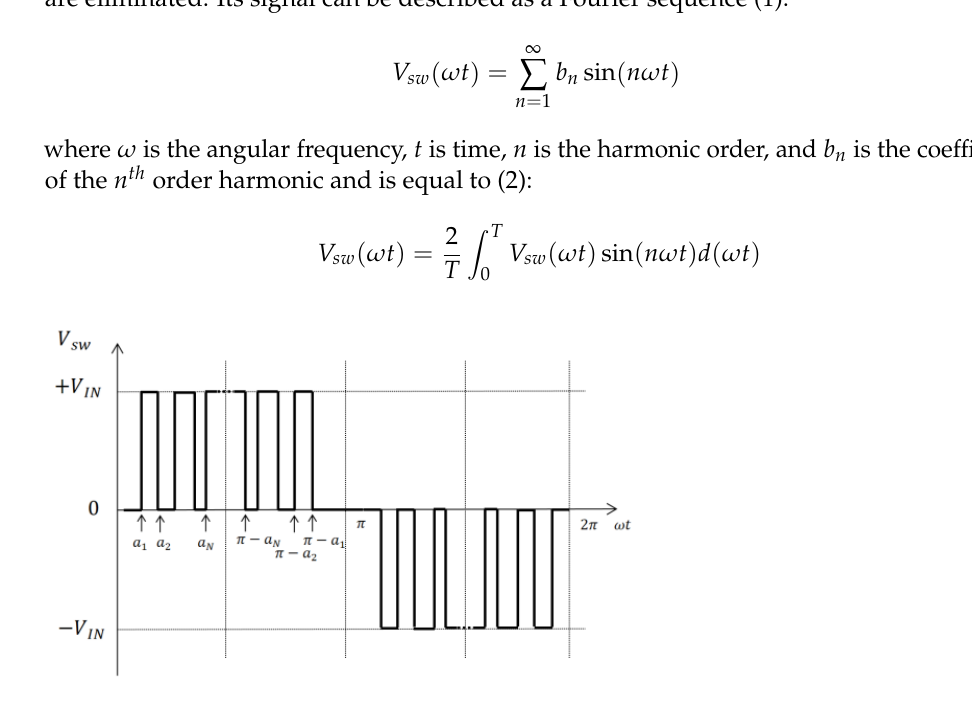
Figure 6. Three-level SHEPWM with N switching angles per